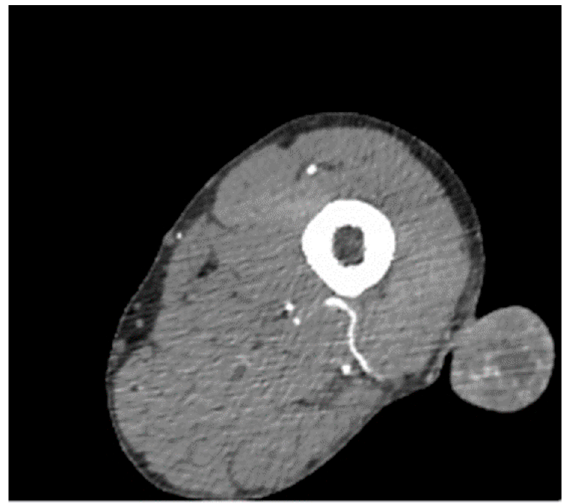
Figure 2. The CT angiographic scan of the lower limb shows the nodular formation with a vascular pedicle connected to the profound femoral artery. Blood vessels are also noticed inside (Supple- mental Material S1).